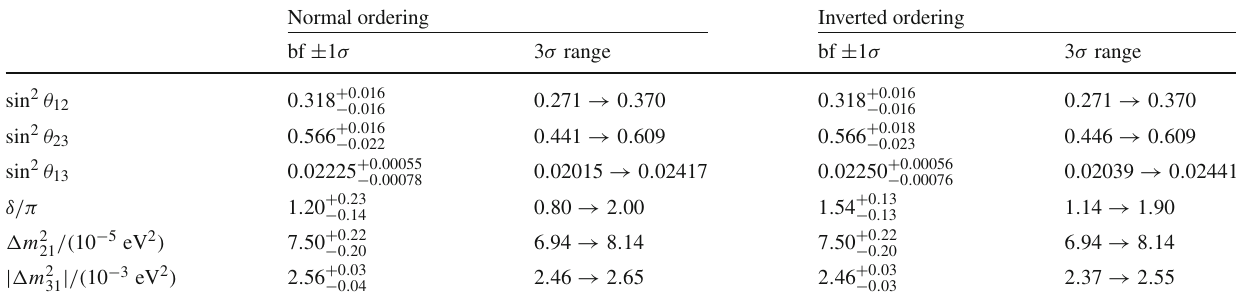
Table 1 The best-fit values, 1 σ errors and 3 σ ranges of six neutrino oscillation parameters extracted from a global analysis of the existing neutrino oscillation data